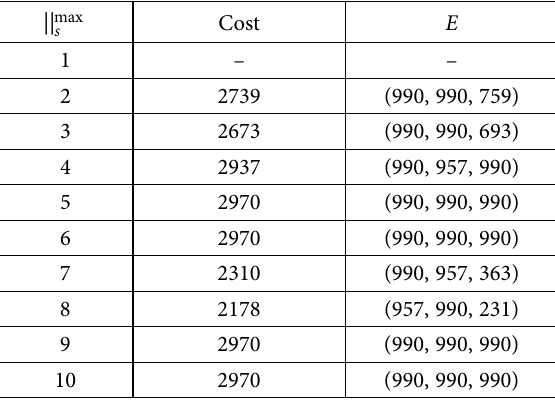
Table 16. The expansion results (no restriction on %